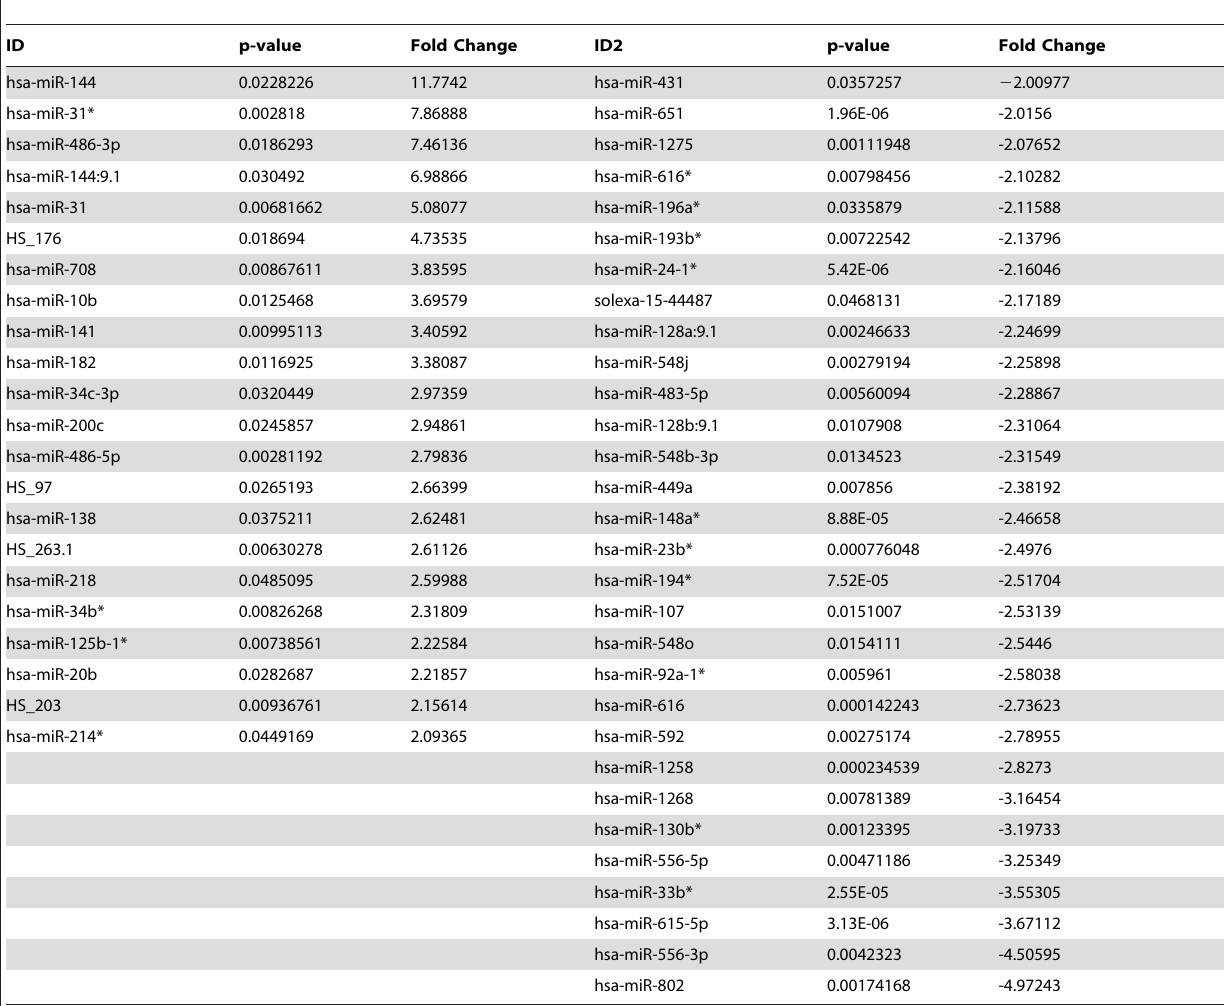
Table 2. miRNA expression profile in chronic